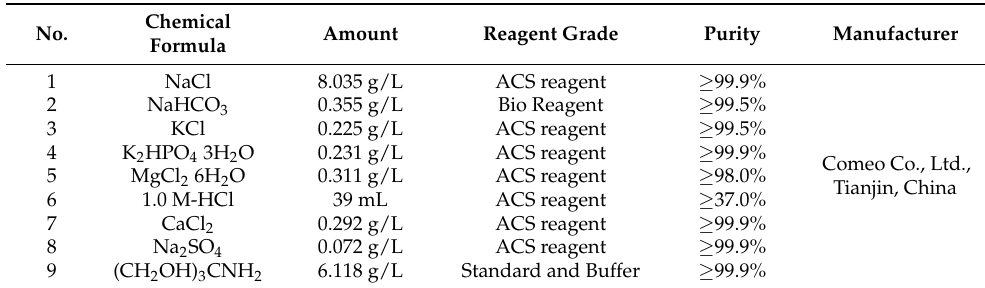
Table 1. Chemical composition and reagents’ grade and purity used for preparation of simulated body fluid